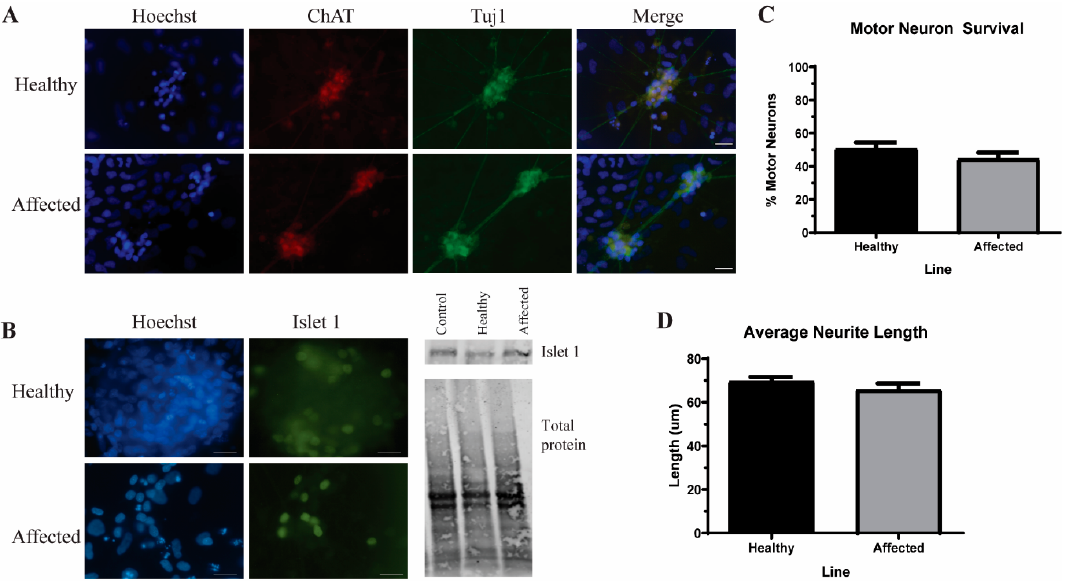
Figure 2. iPSC-derived motor neurons (MNs) from discordant identical twins show no viability or morphological di ff erences. ( A ) Representative images of MNs from healthy and a ff ected lines stained for ChAT (red) and Tuj1 (green). Scale bar = 25 µ m. ( B ) Representative images show nuclear expression of the MN marker islet 1 (green) in both healthy and a ff ected MN cultures. Western Blot for islet 1 also shows similar protein expression across the healthy and a ff ected MN cultures. An unrelated control line was used as an additional control. Protein was normalized to total protein. ( C ) The quantification of A shows no di ff erence in the number of ChAT + MNs at four weeks of total di ff erentiation. n = 3, not significant by Student’s t -test. ( D ) There is no significant alteration in the length of the neurites at 4 weeks of total di ff erentiation. n = 3, not significant by Student’s t